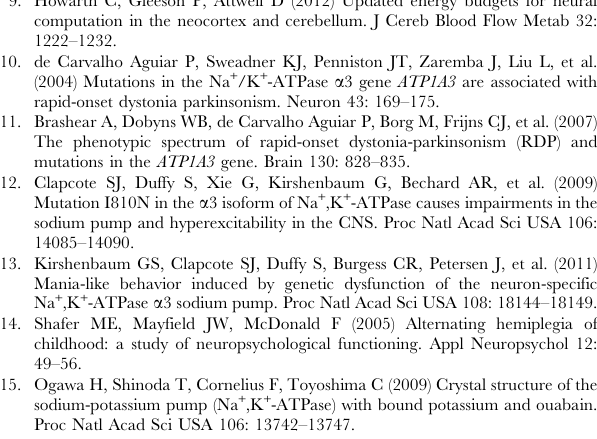
*denotes P , 0.05 significant difference in VIP statistic between genotypes (1000 random permutations). Red highlights regions showing increased and blue decreased functional connectivity with the given seed brain region in Myshkin ( Myk / + ) mice relative to wild-type ( + / + ) controls. Table S4 Full data for ventromedial thalamus (VMthal) functional connectivity. Data shown as the mean 6 SEM of the VIP statistic as determined through PLSR analysis. Bold denotes significant functional connection with the defined seed region in given experimental group (95% CI VIP . 0.80). *denotes P , 0.05 significant difference in VIP statistic between genotypes (1000 random permutations). Red highlights regions showing increased and blue decreased functional connectivity with the given seed brain region in Myshkin ( Myk / + ) mice relative to wild- type ( + / + ) controls. Table S5 Full data for ventral posteromedial nucleus (VPMthal) functional connectivity. Data shown as the mean 6 SEM of the VIP statistic as determined through PLSR analysis. Bold denotes significant functional connection with the defined seed region in given experimental group (95% CI VIP . 0.80). *denotes P , 0.05 significant difference in VIP statistic between genotypes (1000 random permutations). Red highlights regions showing increased and blue decreased functional connectivity with the given seed brain region in Myshkin ( Myk / + ) mice relative to wild-type ( + / + ) controls. Table S6 Full data for dorsomedial periaqueductal grey (DMPAG) functional connectivity. Data shown as the mean 6 SEM of the VIP statistic as determined through PLSR analysis. Bold denotes significant functional connection with the defined seed region in given experimental group (95% CI VIP . 0.80). *denotes P , 0.05 significant difference in VIP statistic between genotypes (1000 random permutations). Red highlights regions showing increased and blue decreased functional connectivity with the given seed brain region in Myshkin ( Myk / + ) mice relative to wild-type ( + / + ) controls. Table S7 Full data for rostral periaqueductal grey (RPAG) functional connectivity. Data shown as the mean 6 SEM of the VIP statistic as determined through PLSR analysis. Bold denotes significant functional connection with the defined